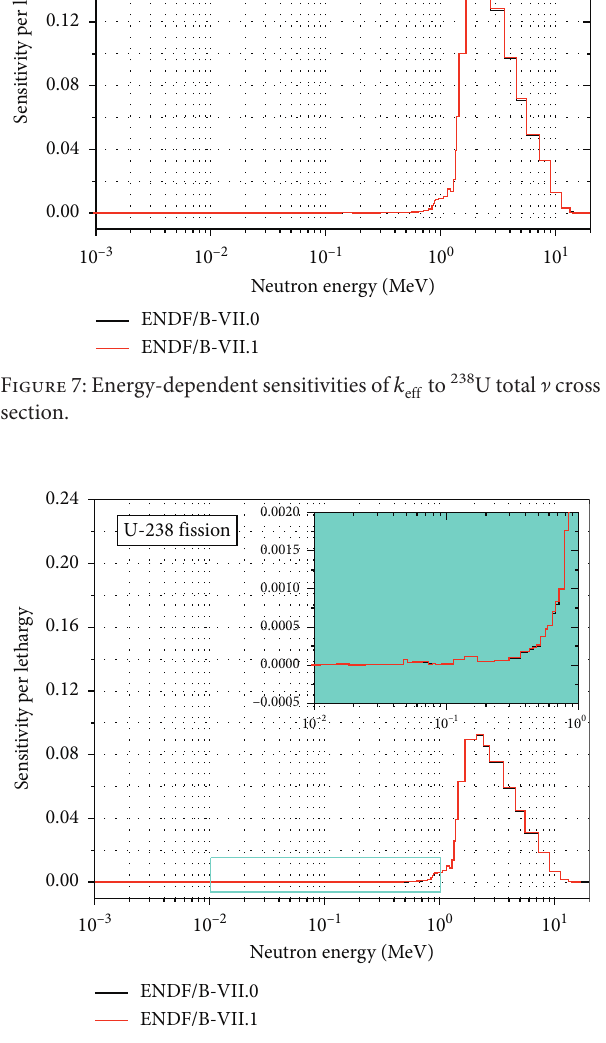
to 238 U fission eff